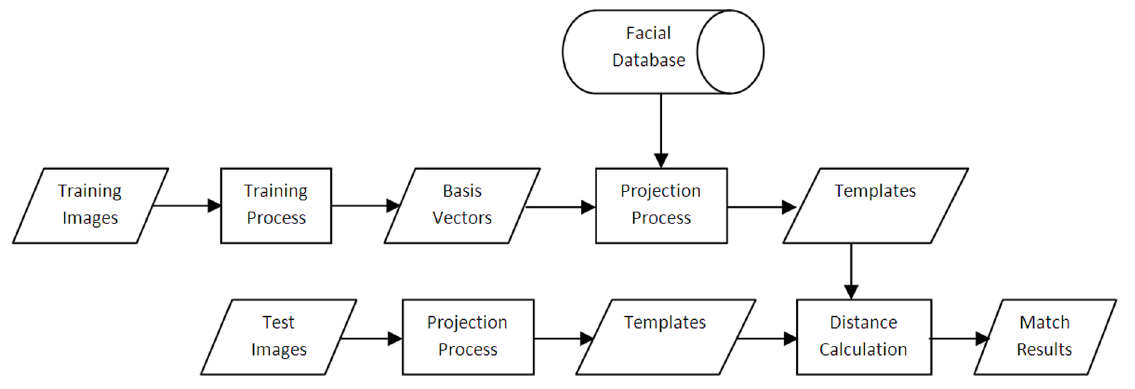
Figure 1. Face Recognition Process.